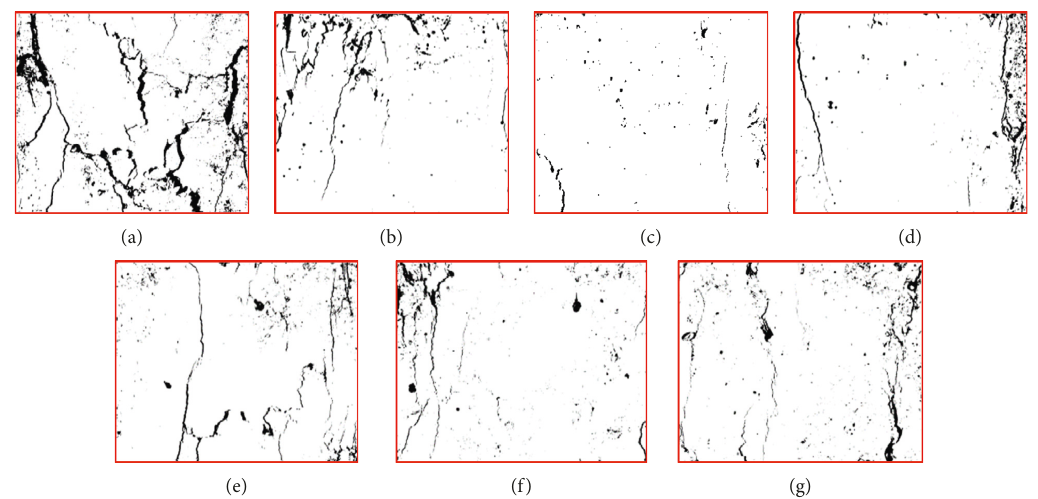
Figure 8: Failure binary images of the concrete at the maximum compressive strength with different RMC contents: (a) 0%, (b) 5%, (c) 10%, (d) 15%, (e) 20%, (f) 25%, and (g) 30%.